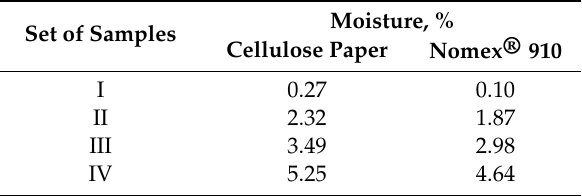
Table 1. Moisture of tested